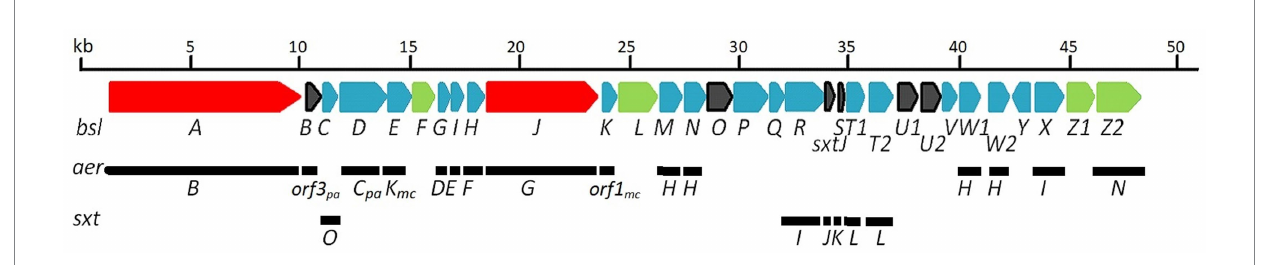
FIGURE 4 bsl -biosynthetic cluster proposed for suomilides: At the top the bsl -gene cluster. Below the indication of which genes are similar to those in the respective gene clusters of aeruginosin ( aer ) and saxitoxin ( sxt ). A detailed description is given in Supplementary Table S29. NRPS genes are given in red, other biosynthetic genes in blue and transporters/transport related genes in green. Open reading frames/hypothetical genes are colored black. Genes found only in Microcystis aeruginosa or Planctothrix aghardii are marked with mc and pa ,